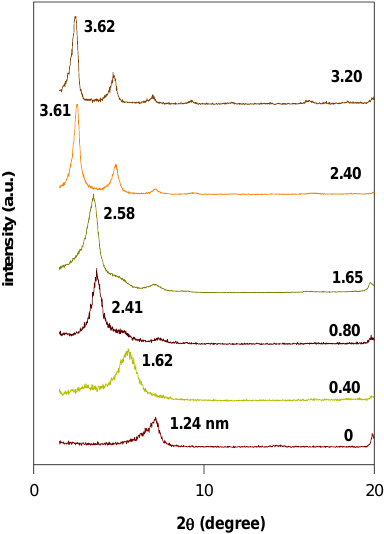
Figure 4. Powder XRD patterns of different OCs prepared from PG clay and C16TMABr solution at different initial loading concentrations (mmol/g).